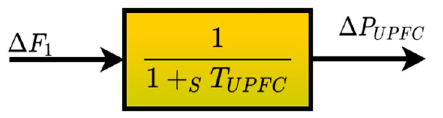
Figure 6. UPFC transfer